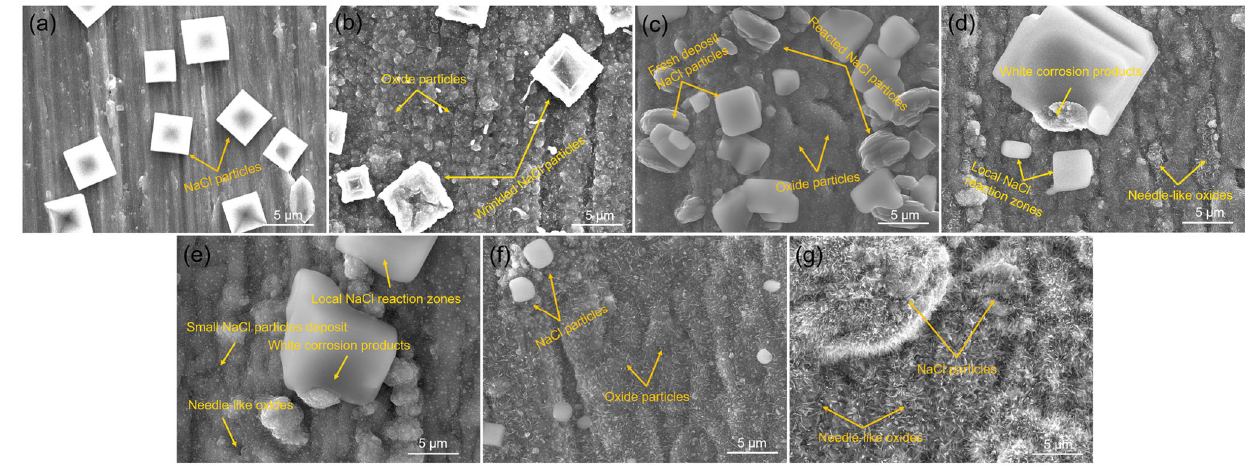
Fig. 3 SEM surface morphologies of samples exposed to the continuous NaCl solution spraying for different times at 600 °C. a 30 s, b 2 min, c 1 h, d , e 5 h, f 10 h, and g 20